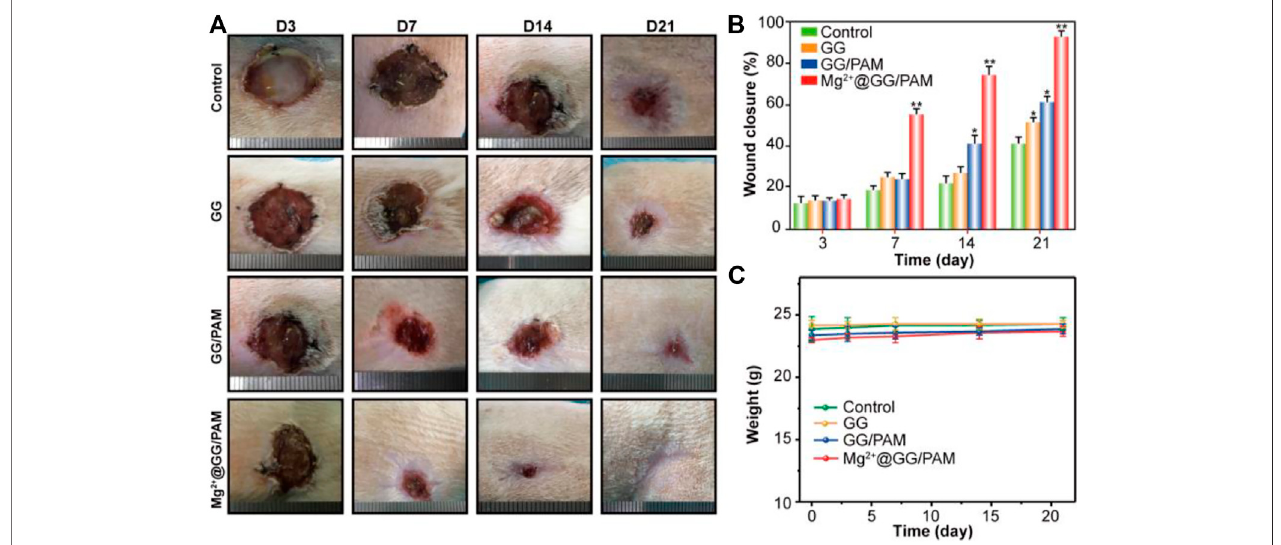
FIGURE 6 | Macroscopic observation (A) , statistical analysis (B) , and weight changes (C) of wound healing process at 3, 7, 14, and 21 days, after treatment with PBS (control), GG, GG/PAM, and Mg 2+ @GG/PAM. The values are represented as mean ± SD ( n (cid:1) 6). * p < 0.05, ** p < 0.01 vs